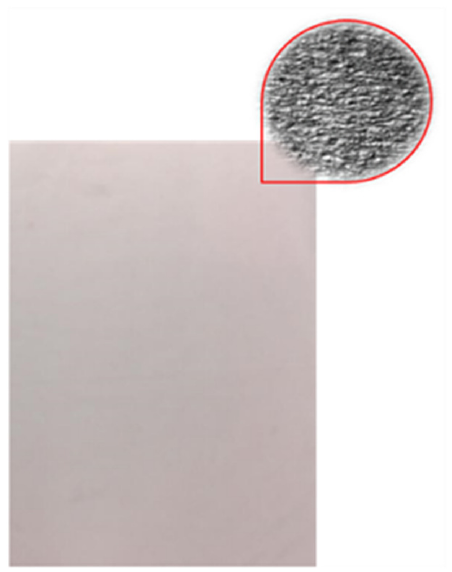
Figure 1. Image of the industrial base tissue paper and the inset showing the crepe structure in a small magnified area.